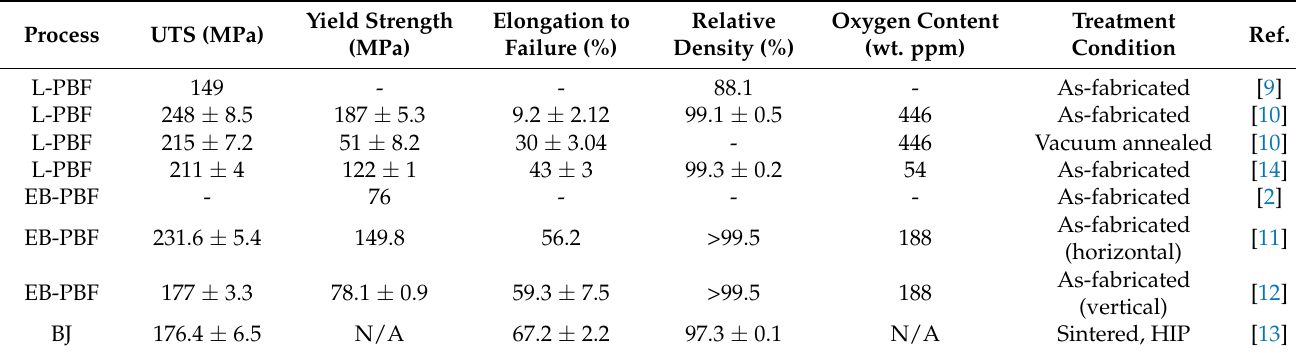
Table 1. Summary of the mechanical properties of BJ, L-PBF, and EB-PBF-processed copper (Best values are taken in each case; horizontal = loading transverse to build direction; vertical = loading parallel to build